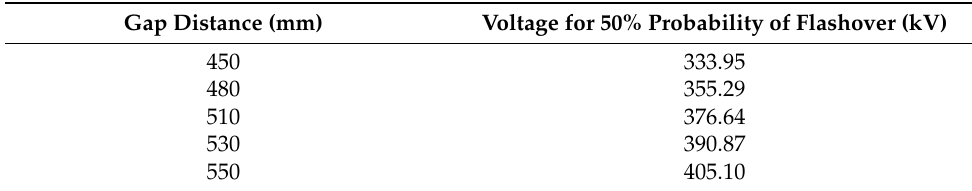
Table 4. The voltage for 50% probability of flashover of parallel